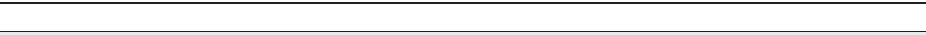
TABLE 1: Patterns of drug